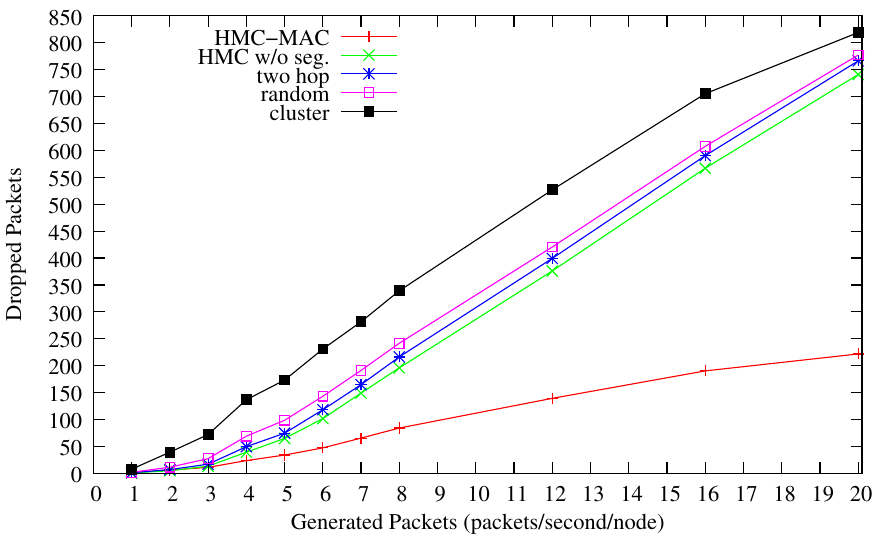
Figure 16. Number of dropped packets for burst